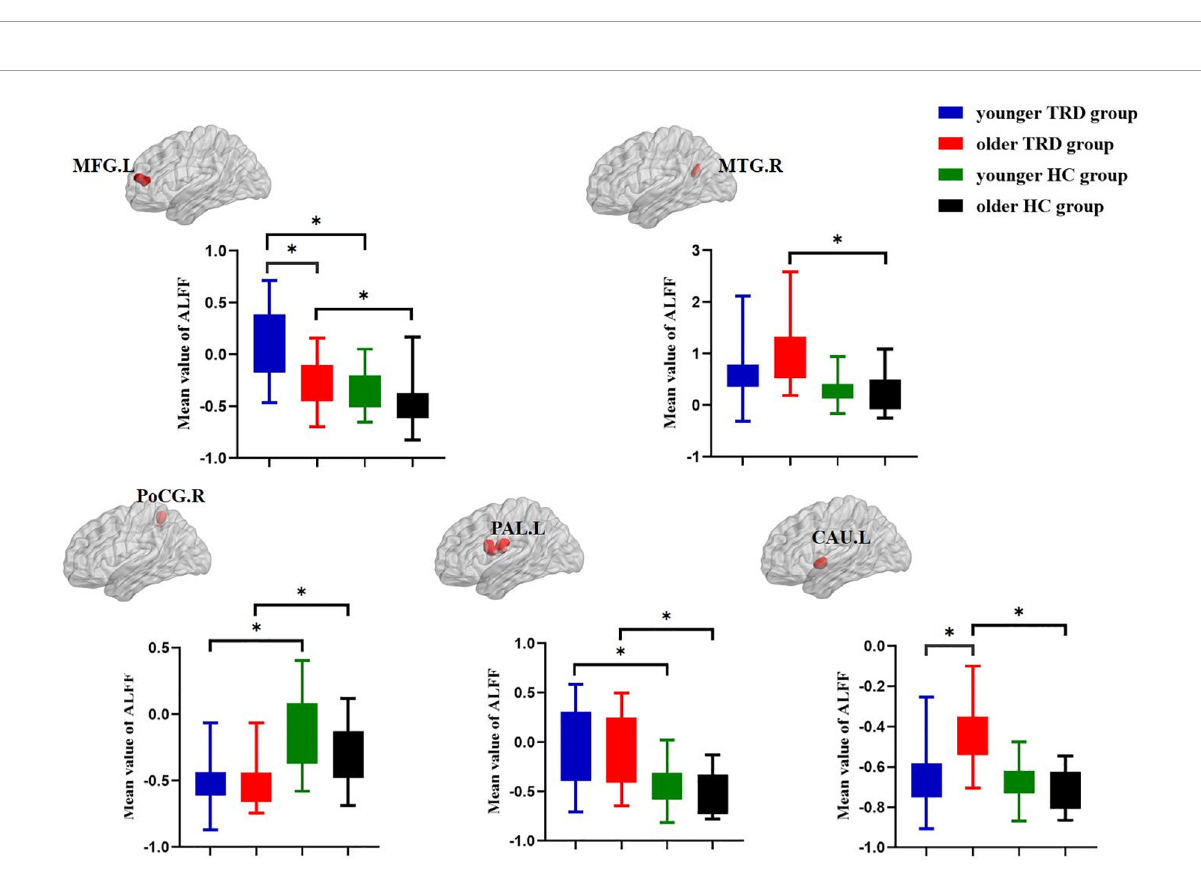
FIGURE2 Post hoc two-sample t -tests (Bonferroni corrected) comparison showing ALFF values differences at peak voxel between each pair group (younger TRD group vs. older TRD group, younger TRD group vs. younger HC group, older TRD group vs. older HC group, younger HC group vs. older HC group). MFG.L, Left middle frontal gyrus; MTG.R, Right middle temporal gyrus; PoCG.R, Right postcentral gyrus; PAL.L, Left pallidum; CAU.L, Left caudate nucleus. * P <